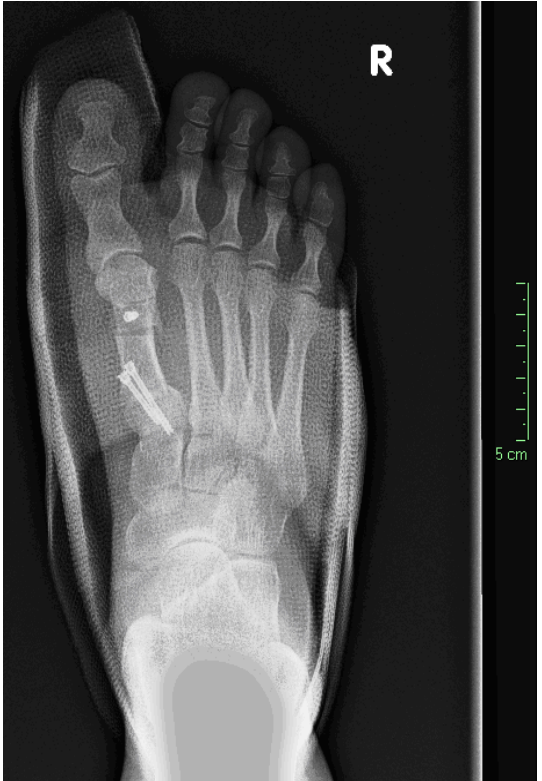
FIGURE 2. Anteroposterior postoperative (2 weeks) appearance in Sabot